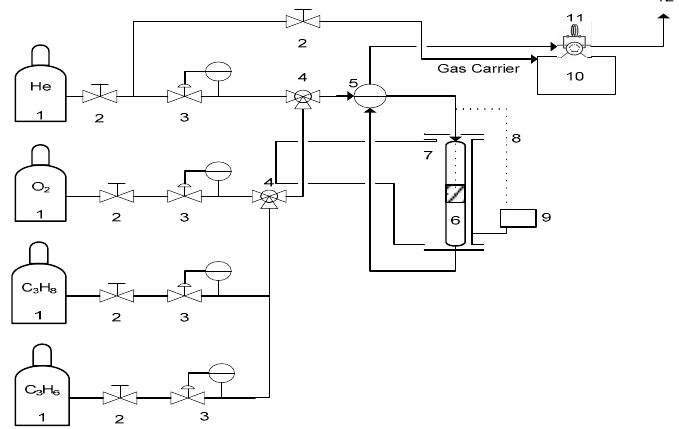
Figure 9. Flow diagram of the reaction system. Components: unit (1) gas cylinders (He, O 2 , C 3 H 8 ,C 3 H 6 ); unit (2) On–off valves; unit (3) mass flow controllers; unit (4) Tee valves; unit (5) four-way valve; unit (6) quartz reactor; unit (7) furnace; unit (8) thermocouple type k; unit (9) thermostat; unit (10) gas chromatograph; unit (11) injection valve; unit (12)